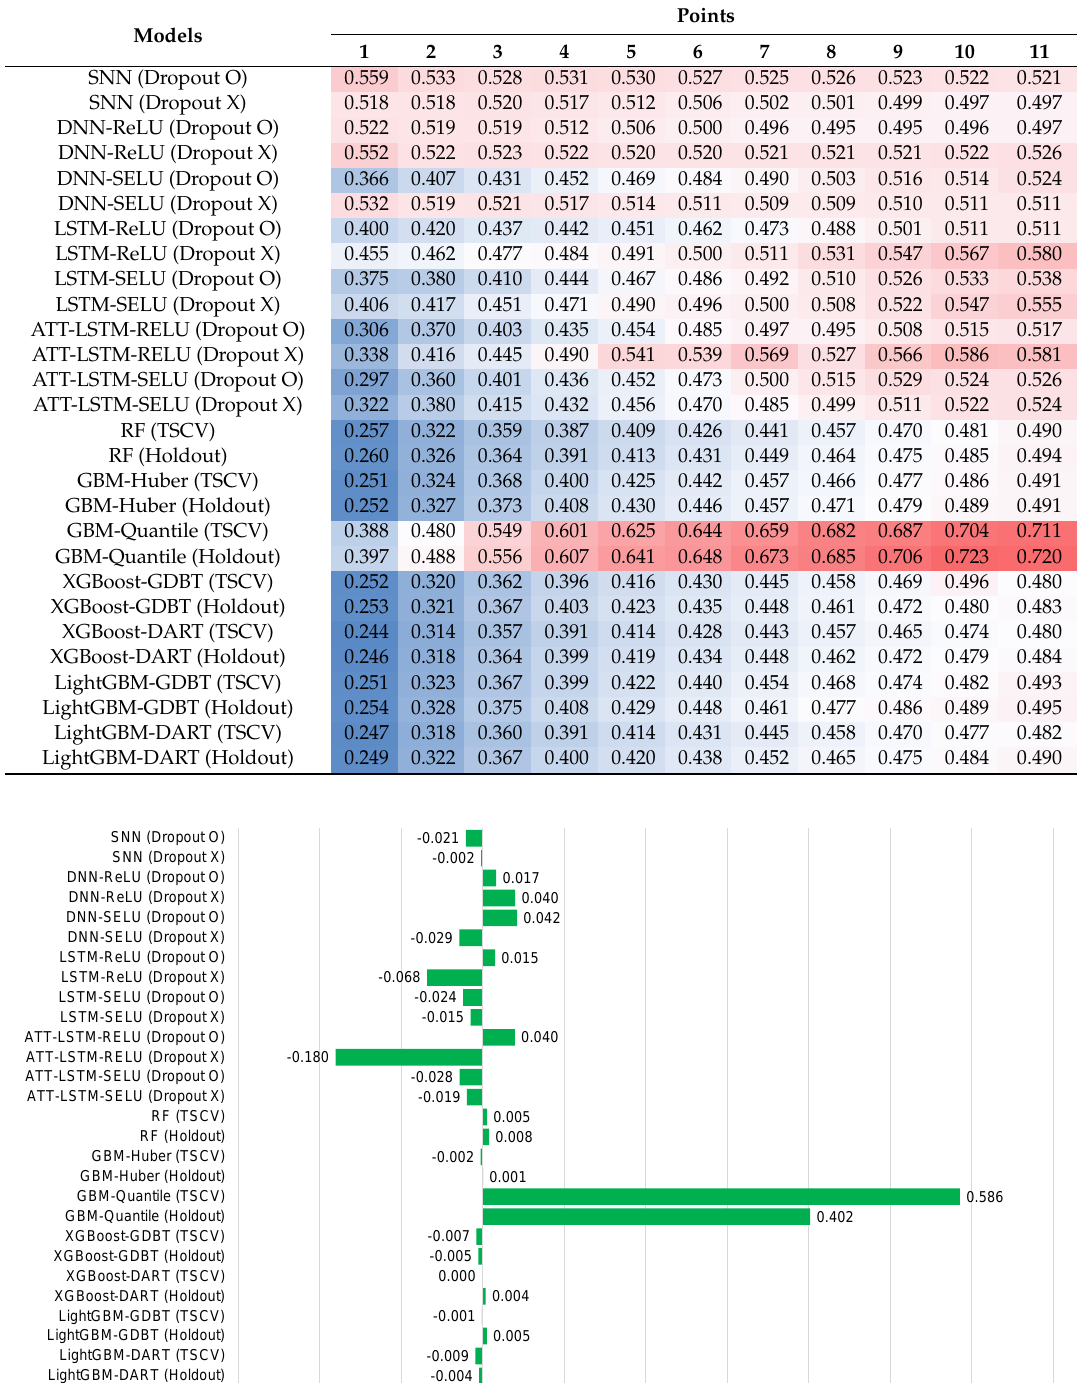
Table 11. Root mean square error (RMSE) distribution for each model for Gosan-ri. A cooler color indicates a lower RMSE value, whereas a warmer color indicates a higher RMSE value (MJ/m 2 ).